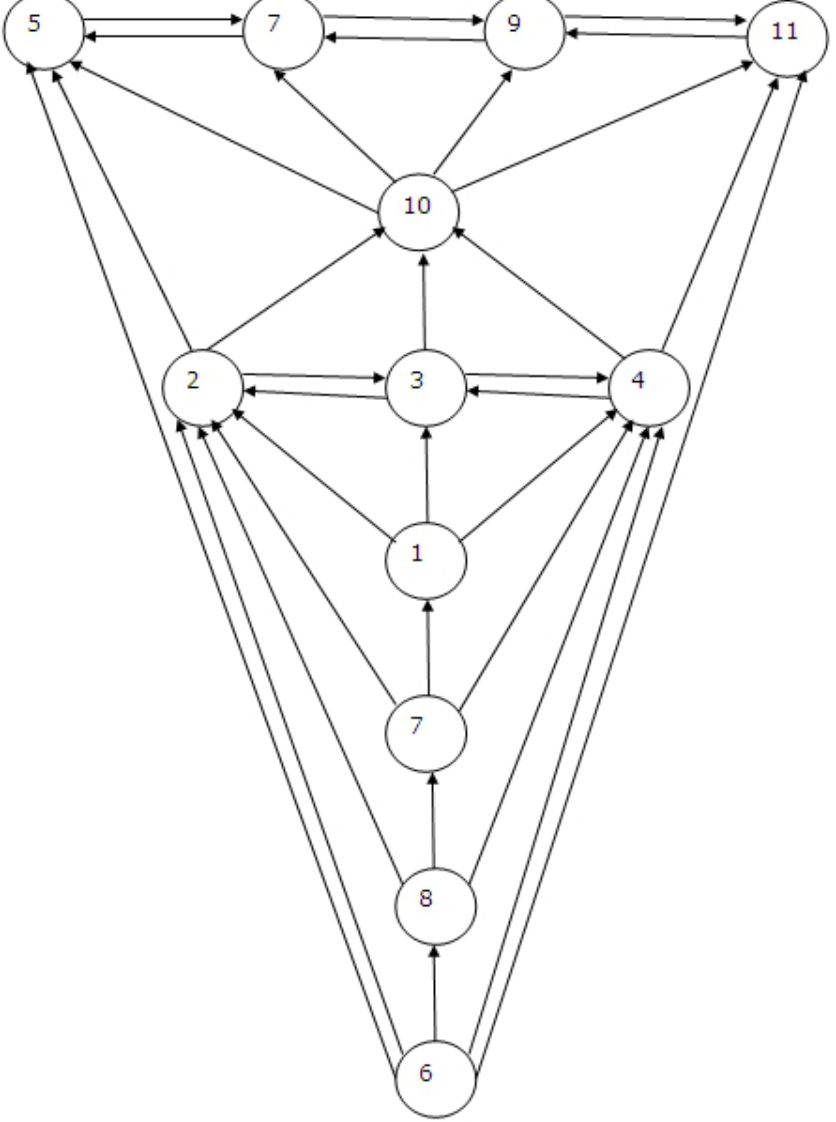
Figure 2. “Digraph of Barriers to Implement GSCM in Indian Automobile